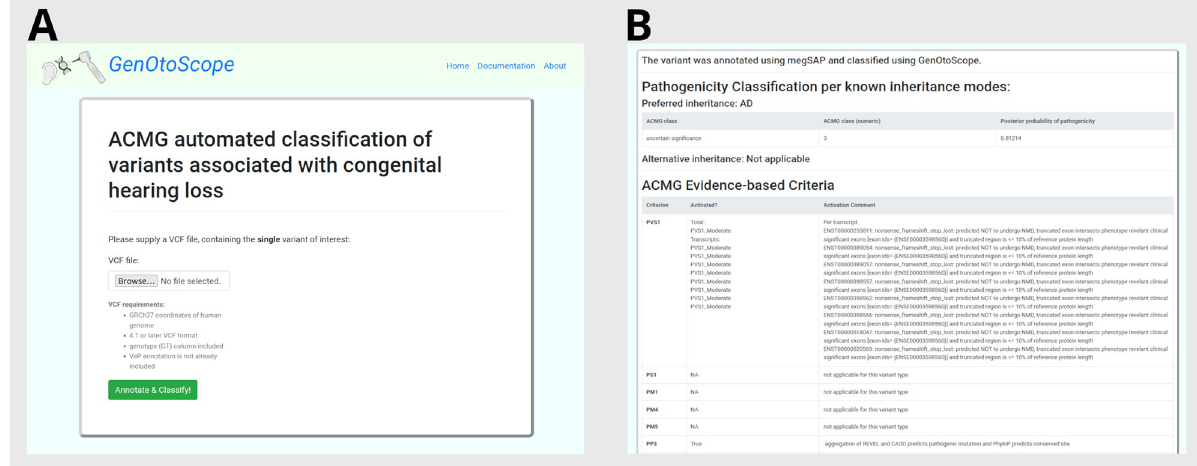
Fig 3. Web interface of GenOtoScope. (A) The home page of the GenOtoScope website. (B) The resulted variant classification page, for an example variant (RS id: 1064797096), which includes its classification based on HL-specified ACMG guidelines.